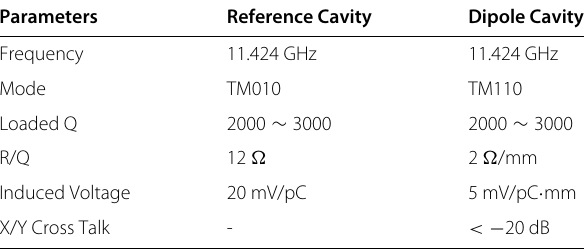
Table 8 Major specifications of the PAL-XFEL undulator